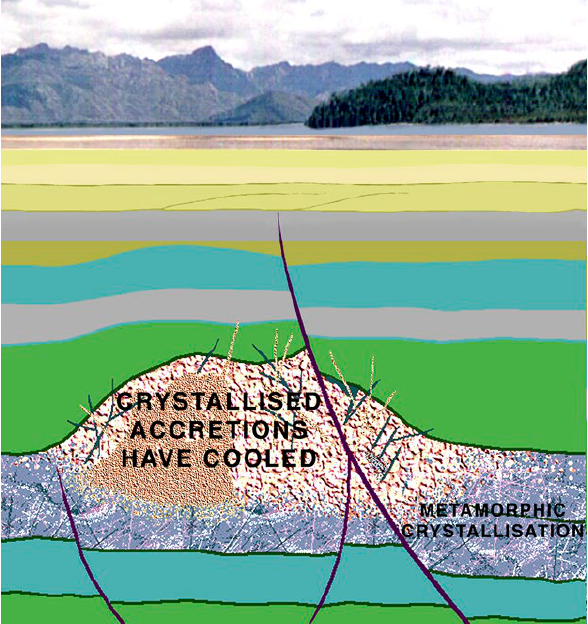
Figure 28. The source of heat including latent heat of fusion that would melt granite plutons remains unknown. Where would the heat come from to selectively melt and re-melt specific large vol- umes of